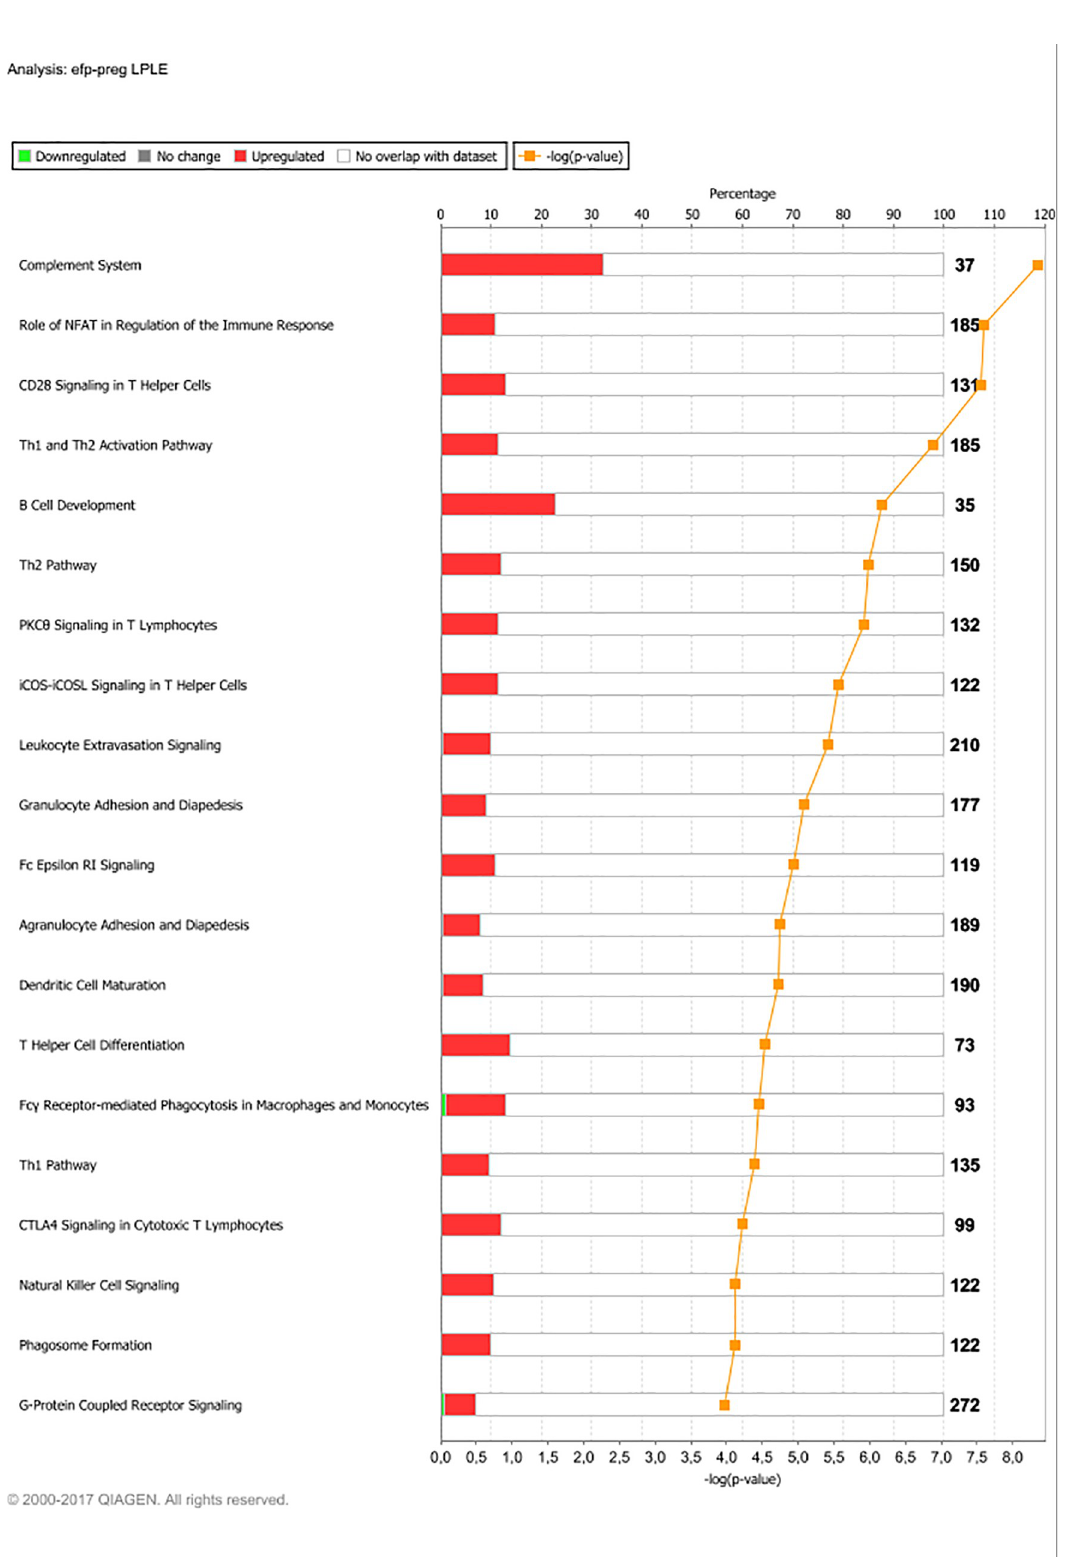
Fig 6. Main affected pathways from experimental feeding period (12MO) to pregnancy (PREG) for Low-protein, Low-energy fed heifers (LPLE). Main affected pathways for LPLE heifers during development from experimental feeding at 12 months of age, to